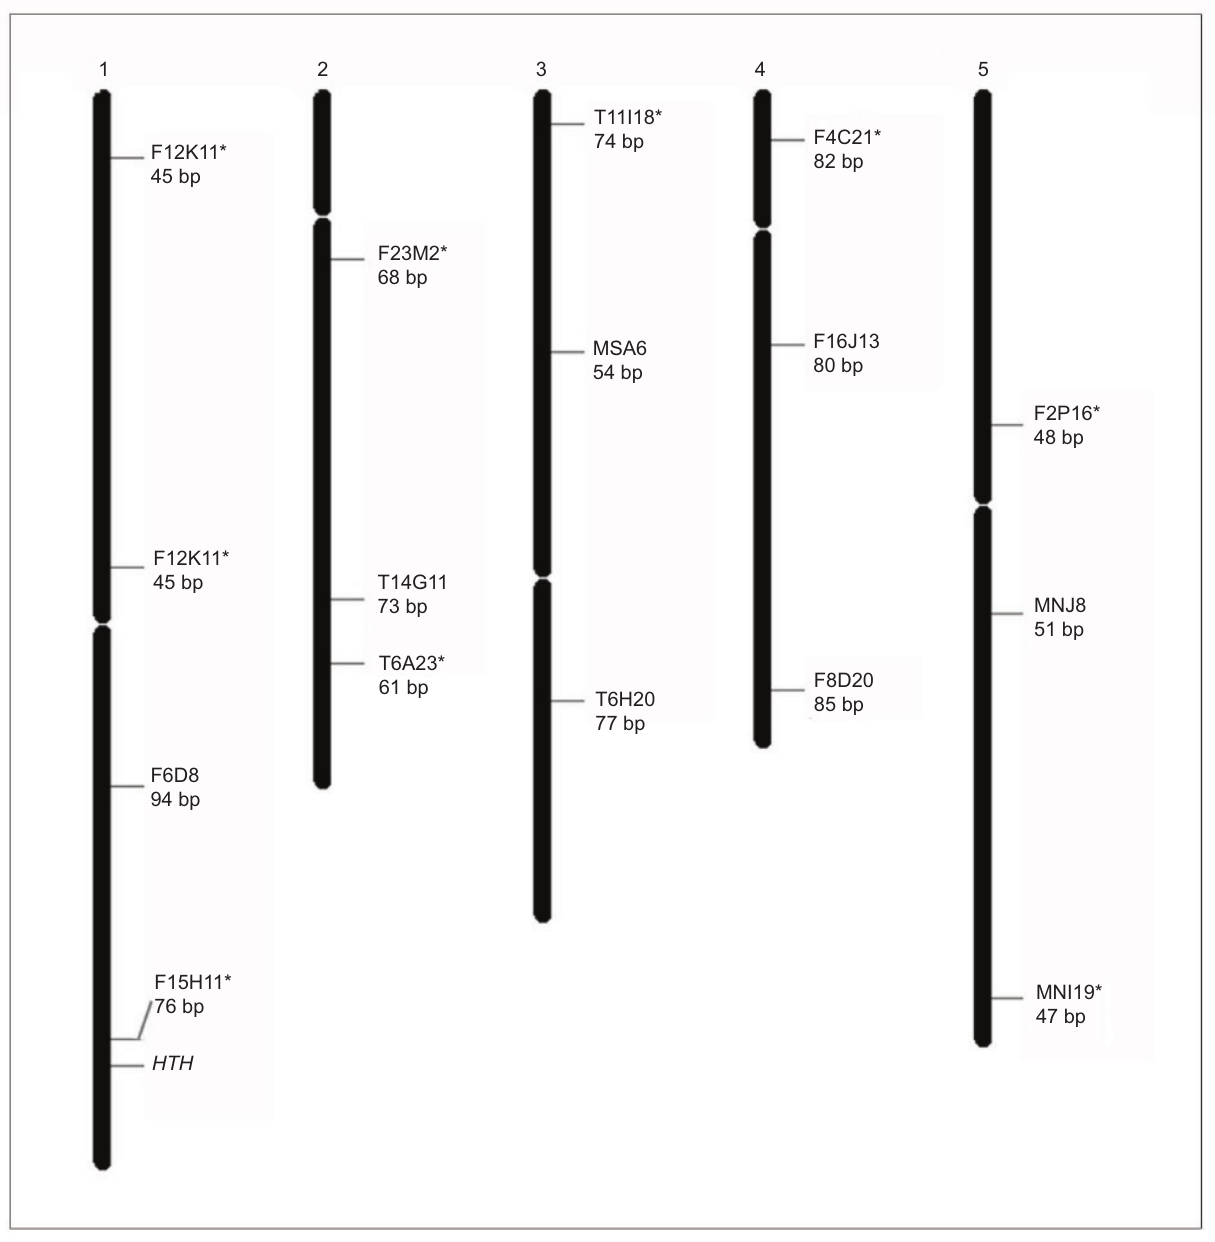
Figure 1. Haploid representation of the 5 Arabidopsis chromosomes indicating the relative locations of the 16 insertion-deletion polymorphic markers used in this study. Nine of the markers are intergenic (*). Marker names reflect clone designations. The size of the insertion sequence is indicated in base pairs (bp). The relative location of HOTHEAD ( HTH ) is shown at the bottom of chromosome